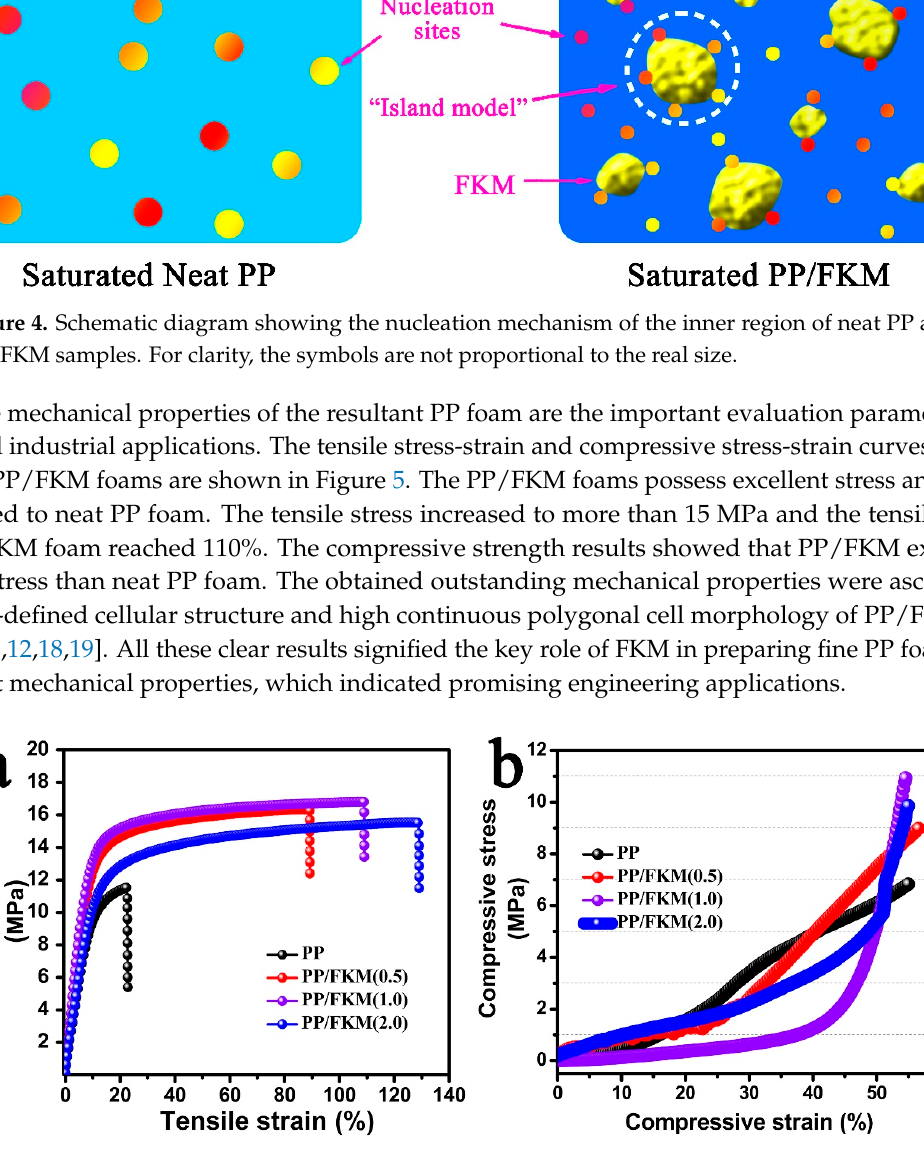
Figure 5. Mechanical properties of neat PP and PP/FKM foams: ( a ) tensile strength and ( b ) compressive